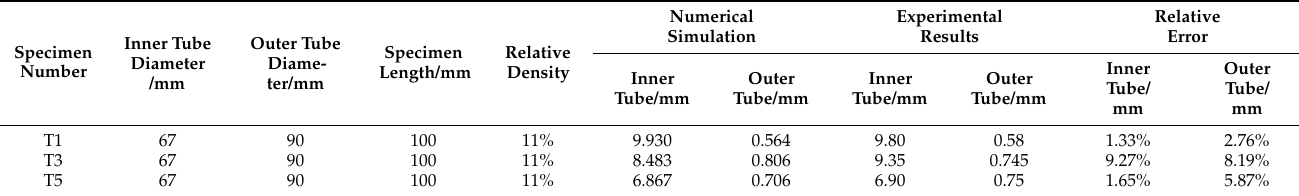
Table 5. Comparison of numerical simulation and experimental